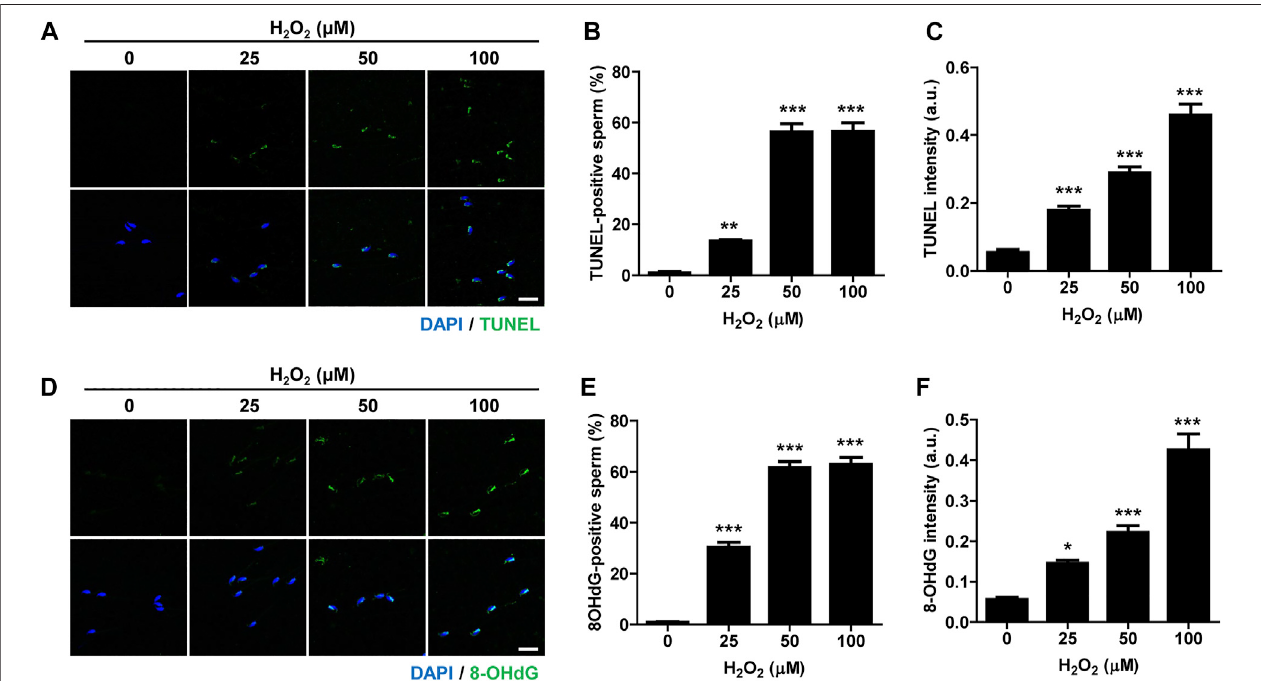
FIGURE1| OxidativestressinducesDNAdamageinspermandimpairsspermmotility.Spermweretreatedwith0,25,50,and100 μ Mhydrogenperoxide(H 2 O 2 ) for1 h.Sperm DNAfragmentationwasassessed byTUNELassayand8-OHdG staining. (A – C) TUNEL-positivesperm andTUNELintensitywerequanti fi ed andshown with representative images. (D – F) 8-OHdG-positive sperm and 8-OHdG fl uorescence intensity were quanti fi ed and shown in representative images. Scale bar, 10 μ m. Data are expressed as mean +SEM. * p < 0.05, ** p < 0.001, and *** p < 0.0001, compared to control (0).